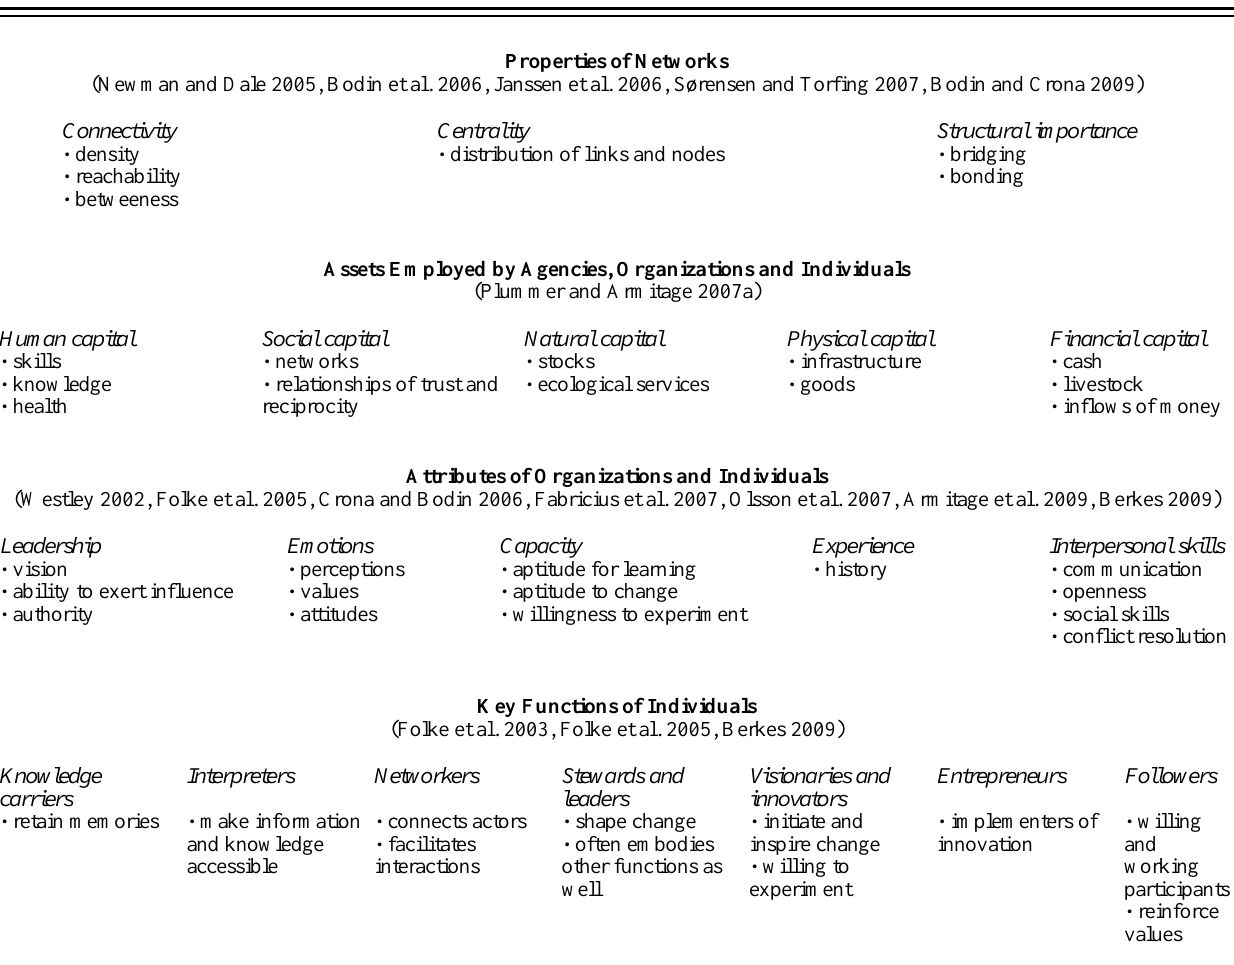
Table 2. Analytical framework of endogenous variables influencing the process of adaptive co-